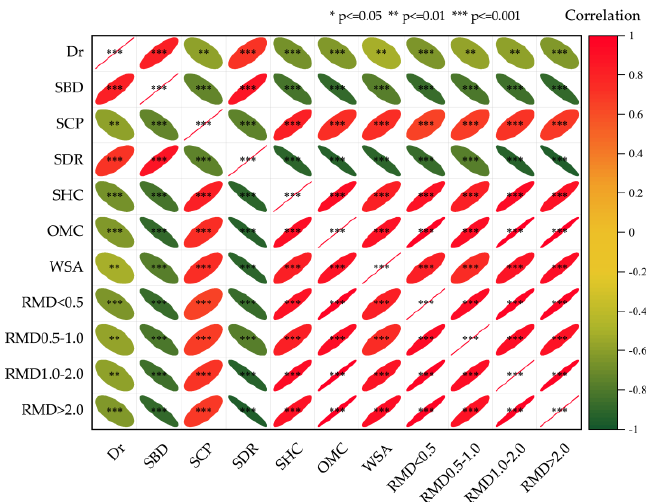
Figure 6. Correlation matrix among soil detachment rate, soil properties, and root mass density. Note: Dr, SBD, SCP, SDR, SHC, OMC, WAS, RMD < 0.5, RMD 0.5–1.0, RMD 1.0–2.0, and RMD > 2.0 refers to the soil detachment rate, soil bulk density, soil capillary porosity, soil disintegration rate, saturated soil hydraulic conductivity, organic matter content, water-stable aggregate, root mass density of <0.5 mm, root mass density of 0.5–1.0 mm, root mass density of 1.0–2.0 mm, and root mass density of >2.0 mm, respectively.